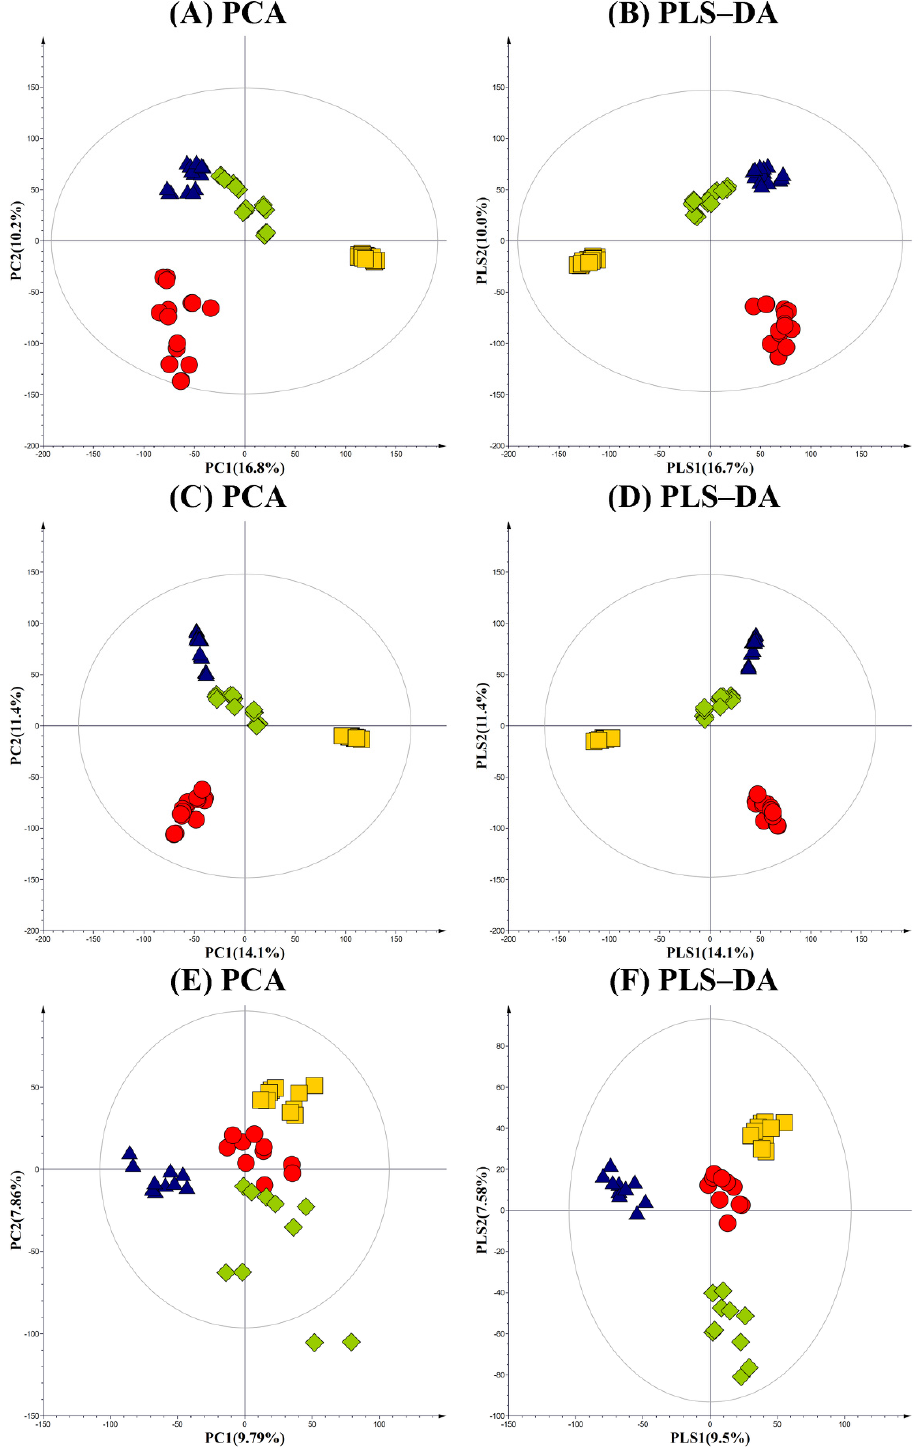
Figure 2. PCA and PLS-DA score plots, derived from the ( A , B ) GC-TOF-MS; ( C , D ) UHPLC-LTQ- Orbitrap-MS dataset; and ( E , F ) HS-SPME / GC-TOF-MS. The datasets are indicated - ■; soy, - ● ; cheonggukjang, ◆ ; meju, ▲ ; doenjang.